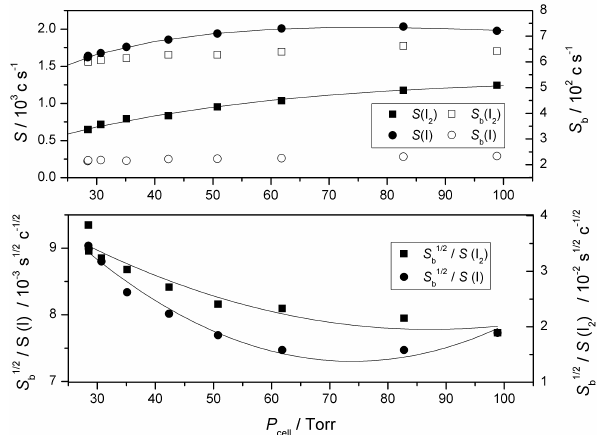
Fig. 4. Pressure dependence of I and I 2 fluorescence signal (SBT = 243K). Top panel: Fluorescence signal (full symbols, left axis) and background (empty symbols, right axis) vs. pressure in the cell. Solid lines are fits of explicit forms of Eqs. (1) and (2) to the experimental data. Bottom panel: ratio of the square root of the background signal to fluorescence signal vs. pressure in the cell. Solid lines are polynomial fits to the